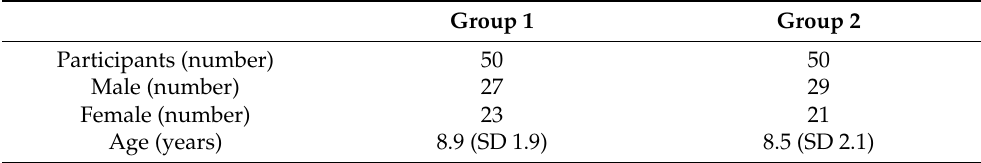
Table 1. Description of main characteristics of patients.